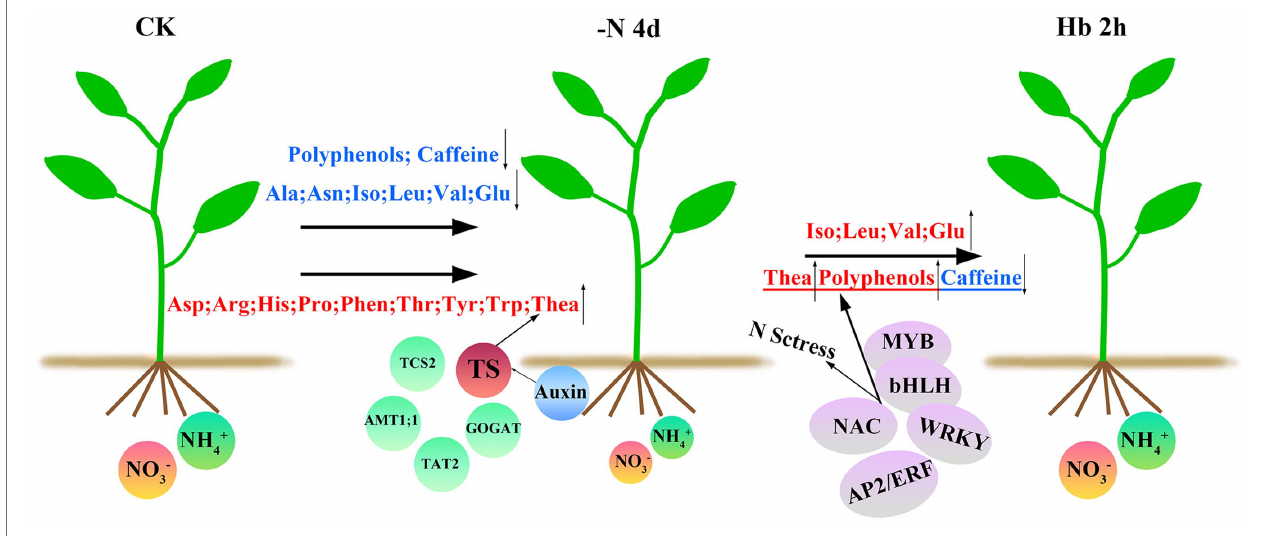
FIGURE 8 | A working model for N-regulation of AAs, polyphenols, and caffeine metabolism during N deprivation and resupply in C. sinensis roots. N deficiency resulted in a decrease in some AAs, caffeine, and most polyphenols, but an increase in the other AAs, such as theanine. These results may be influenced by a variety of factors, including the regulation of tea physiological properties, such as a preference for NH 4 + , and the roles of some important transporters, TFs, and hormones in secondary metabolism and stress tolerance. After N recovery, the contents of most down-regulated AAs and polyphenols recovered, but caffeine did not. The substances were shown above and below the arrows, with blue for downregulation and red for up-regulation. TS and the four circles around it represent the five key genes screened in this experiment. TFs in the purple ellipse were the most active TFs in N deficiency, which participated in N starvation response and regulated the synthesis of theanine, polyphenols, and